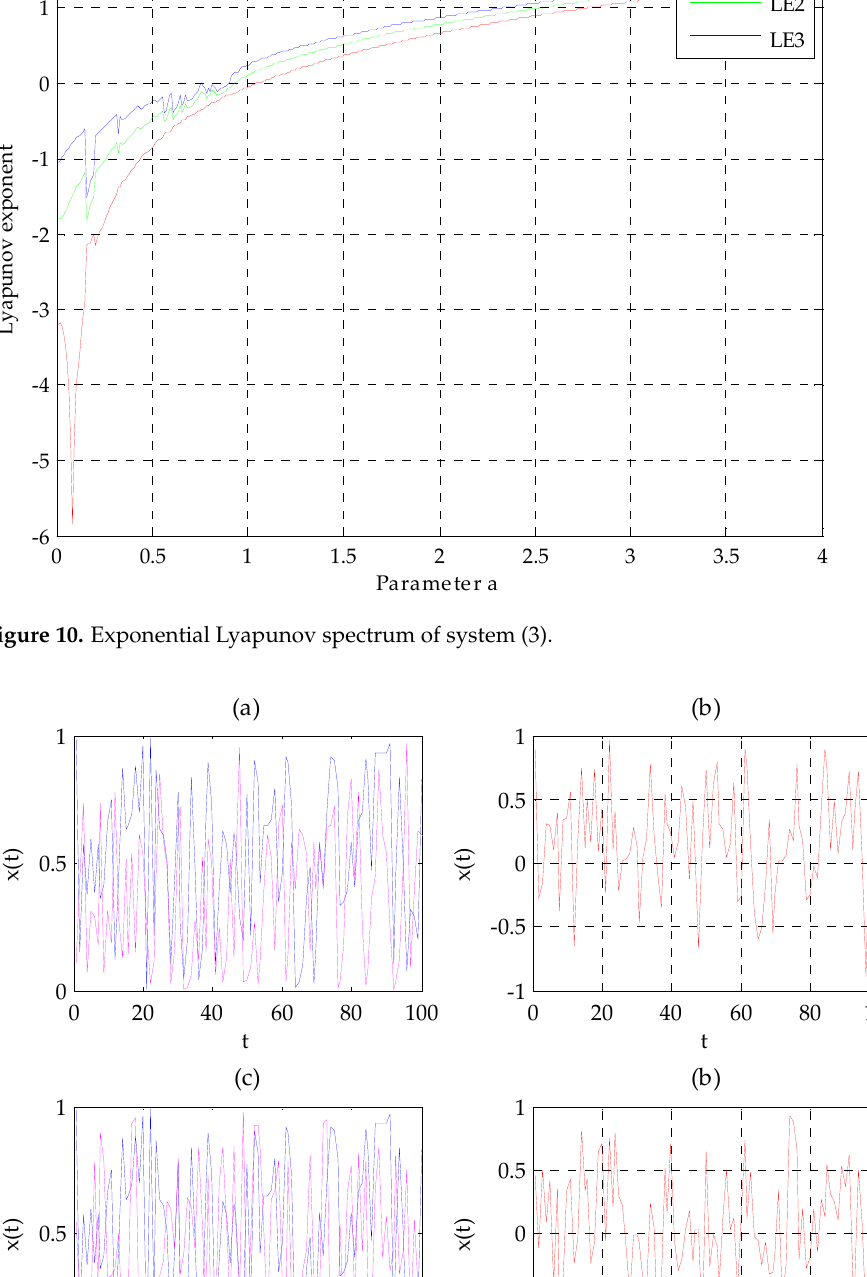
Figure 9. Phase diagram of system (3): ( a ) X–Y phase diagram; ( b ) X–Z phase diagram; ( c ) Y–Z phase diagram; ( d ) X–Y–Z phase diagram.